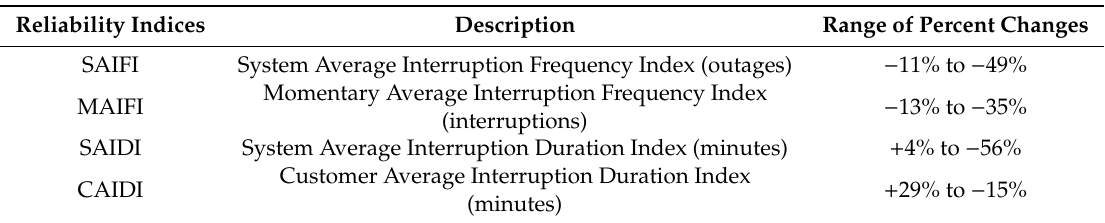
Table 1. Changes in Reliability Indices from Automated Feeder Switching.